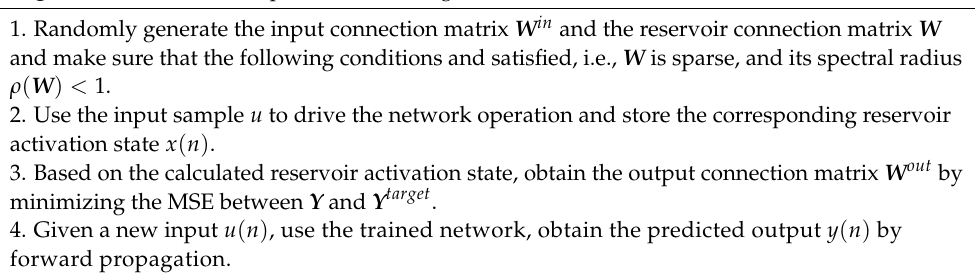
Algorithm 1 The Main Steps for the Training and Prediction of an ESN